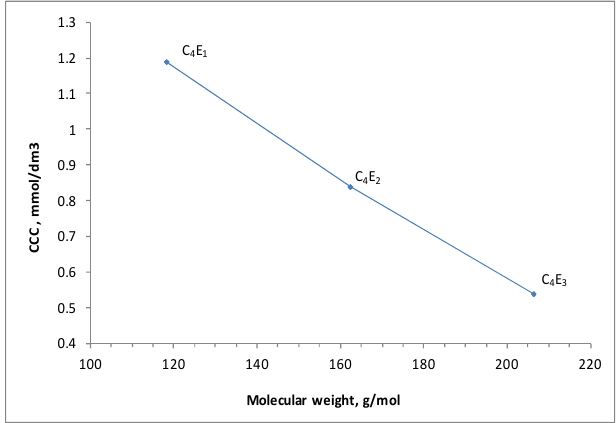
Figure 7. Correlation between CCC and MW for C 4 E 1 , C 4 E 2, and C 4 E 3 .